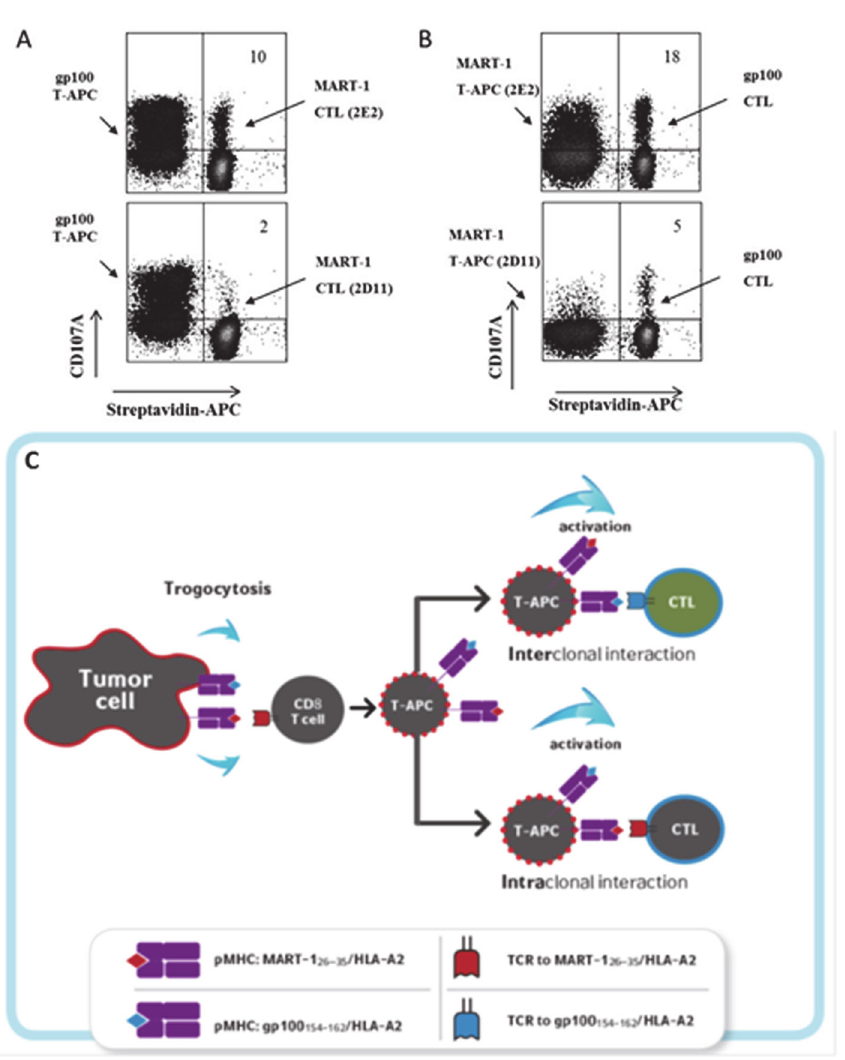
Fig 2. CD8 + T-APCs induce degranulation of effector CTLs with different antigen specificity. ( A, B ) CD8 + clones with different antigen specificity were used as CD8 + T-APCs and effector CTLs. Biotinylated effector CTLs were co-cultured with CD8 + T-APCs, stained with anti-CD107A mAb and streptavidin- allophycocyanin and analyzed by flow cytometry. ( A ) The gp100 154 – 162 -specific clone 1G2 was used as CD8 + T-APC for the MART-1 26 – 35 -specific CTL clones (2E2 and 2D11). (B) The MART-1 26 – 35 -specific clones 2E2 and 2D11 were used as CD8 + T-APC for the gp100 154 – 162 -specific clone (1G2). Numbers in upper right quadrants indicate the percentage of CD107A + streptavidin + lymphocytes, gated on the CD8 + population (effector CTLs). Data are representative of three independent experiments. ( C ) Graphic presentation of intra- and inter-clonal T cell cross talk.